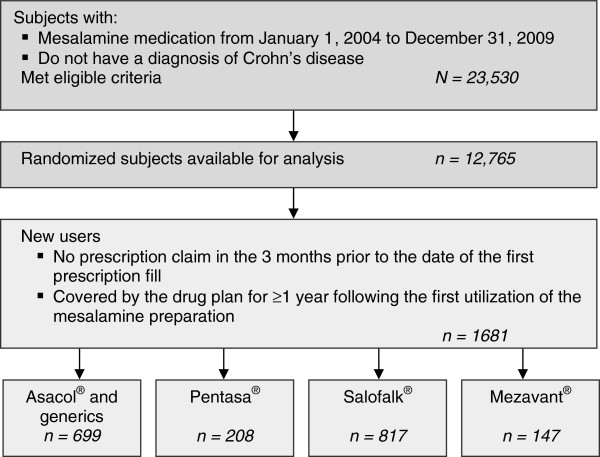
Sample selection and attrition.